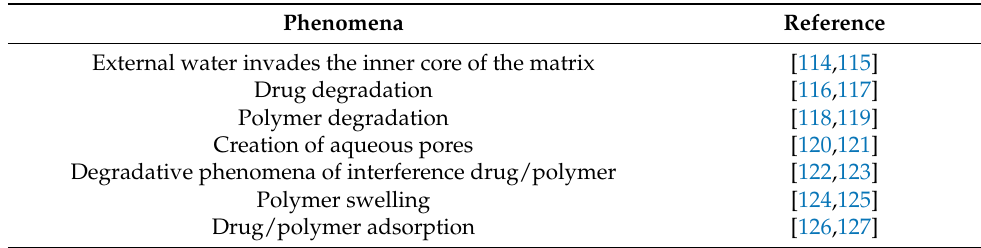
Table 3. Phenomena of